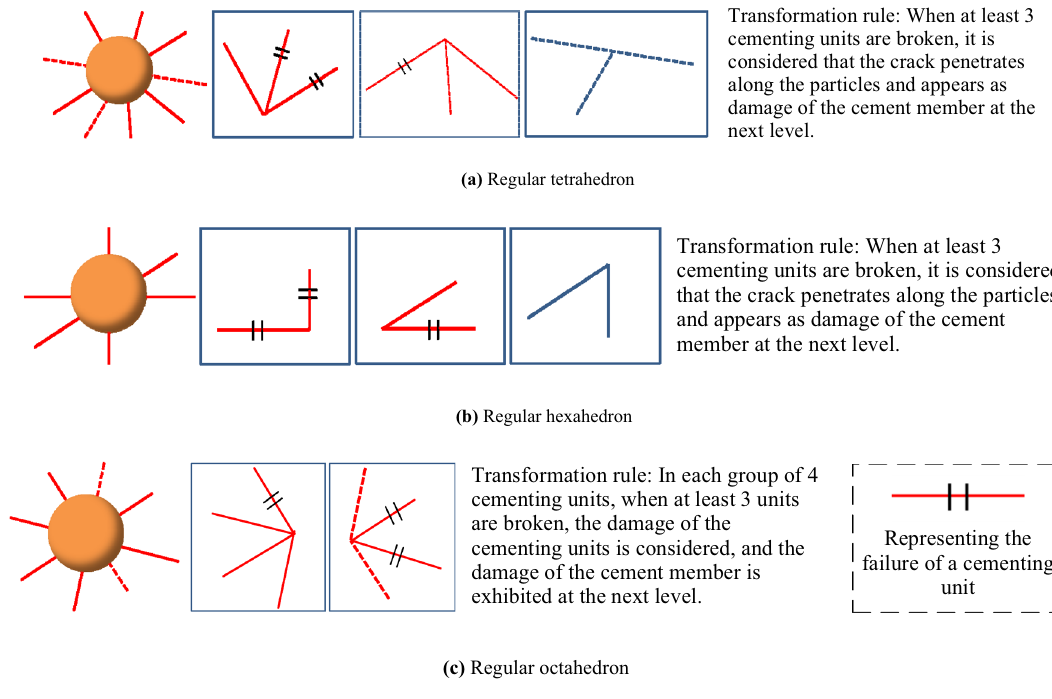
Fig. 6 Destruction rule of granule-centered microstructural units of the weakly cemented sandstone: a regular tetrahedron, b regular hexahedron, c regular and the transformation rule of the microstructural units centered on pores is shown in Fig. 7.